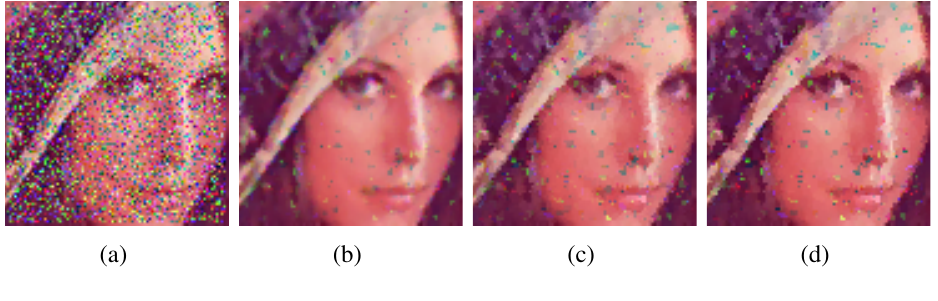
Figure 3. (a) Lenna image corrupted with random-value impulse noise with p = 0 : 3 in each colour channel and outputs from: (b) VMMF, (c) VMF and (d) proposed